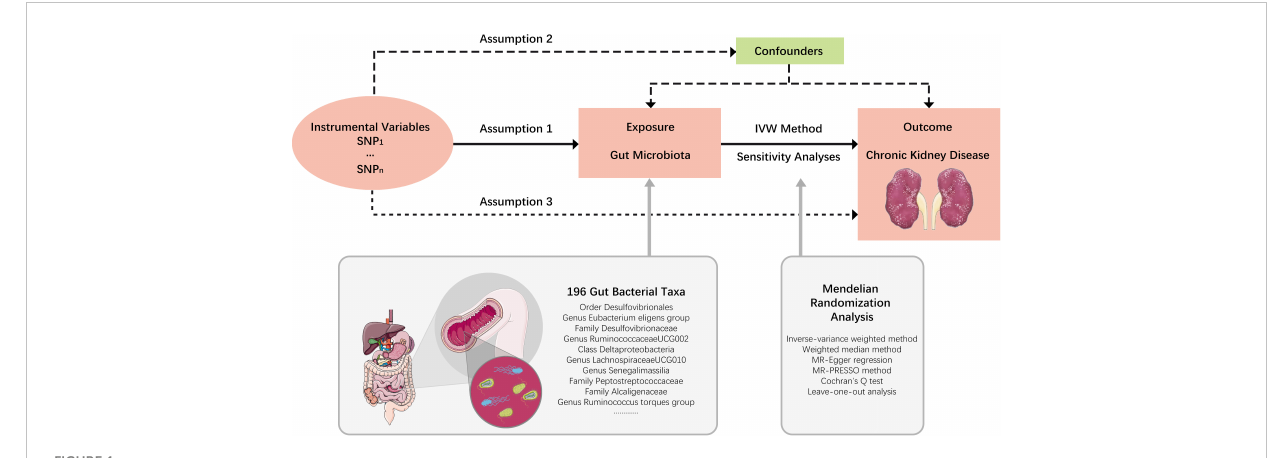
FIGURE 1 Study design. An overview of the study design. SNP, single nucleotide polymorphisms; IVW, inverse-variance